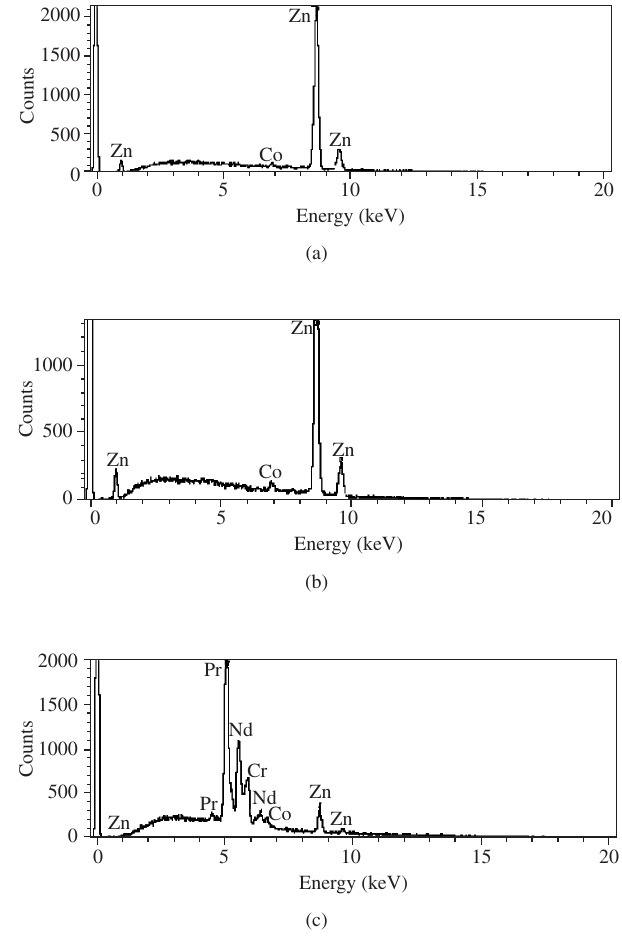
Figure 5. EDS analysis of ZPNC-2 varistor ceramic: a) ZnO grain (X-marked, Figure 4a); b) Grain Boundary region (Z-marked, Figure 4a) and c) IGL region (Y-marked, Figure 4a).